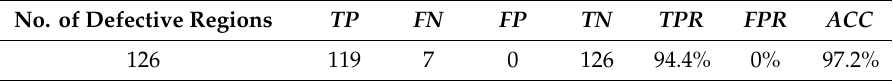
Figure 19. Evaluation criteria for regional comparison. Table 4. Evaluation results of 126 defects in 85 images.